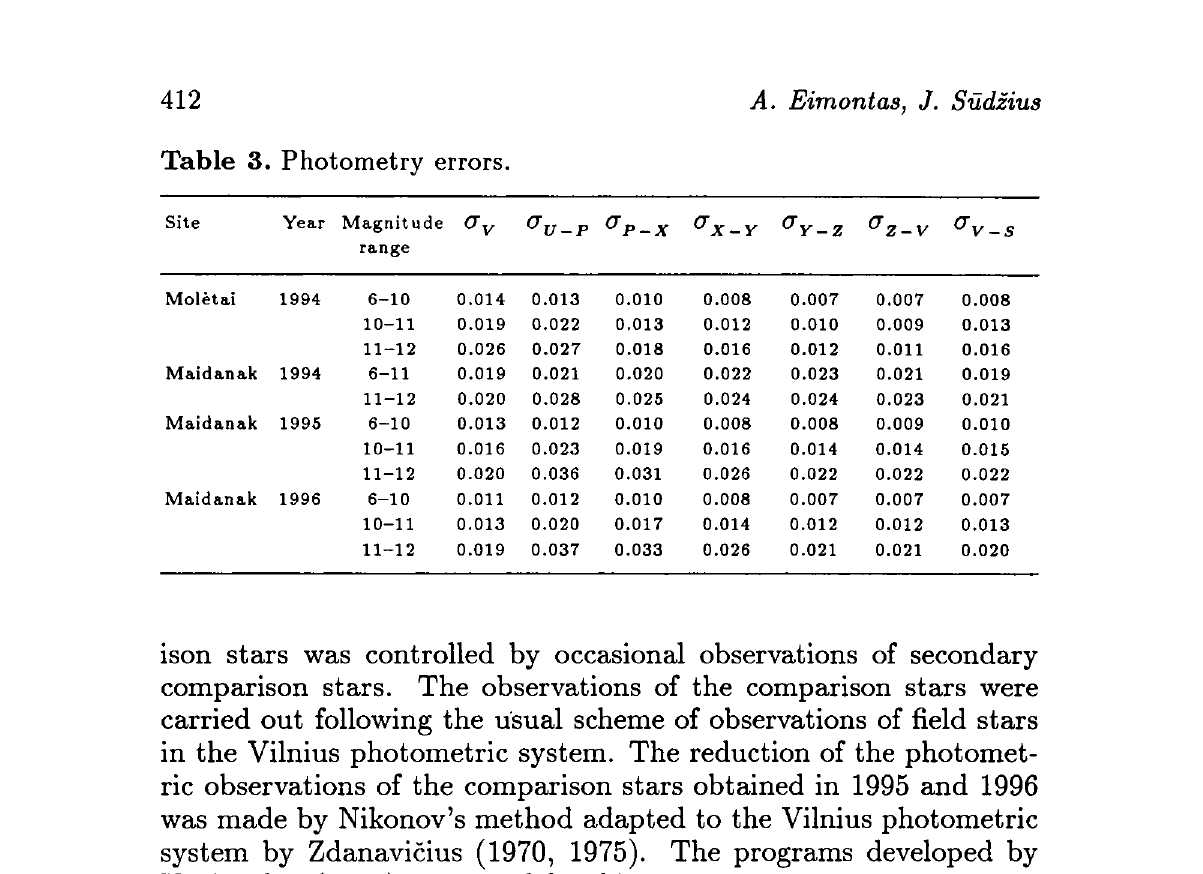
Table 3. Photometry